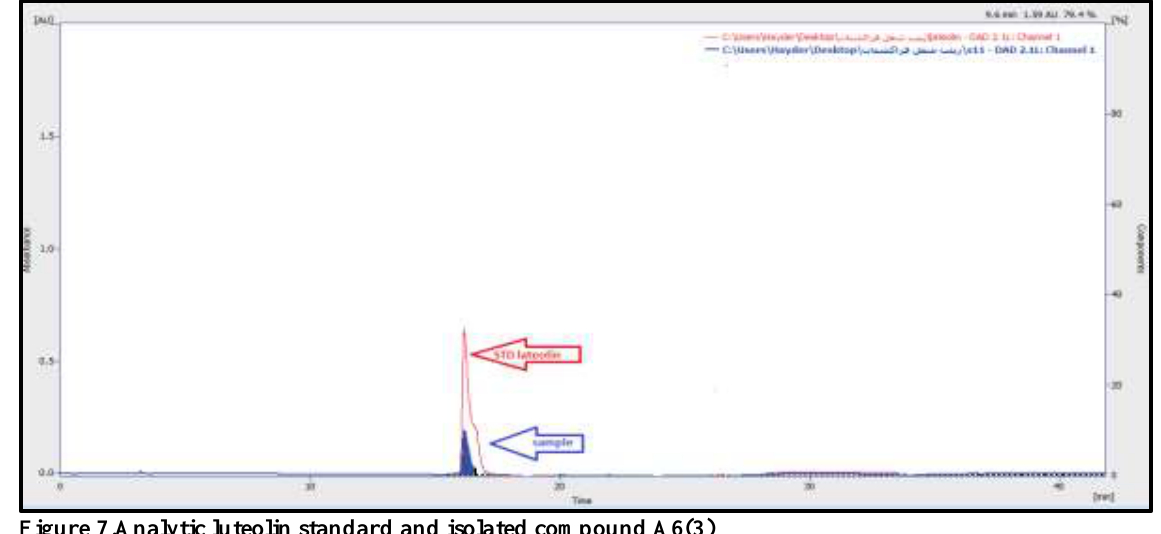
Figure 6. UV spectrum for apigenin standard and isolated compound A4(1) HPLC for isolated compound (A6) (3) and. luteolin standard HPLC results show in Figures (7- 8) :